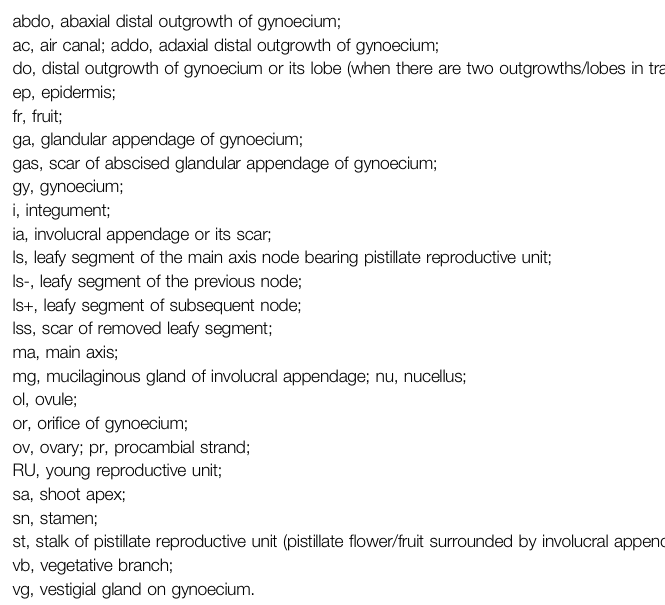
List of abbreviations in fi gures with anatomy and